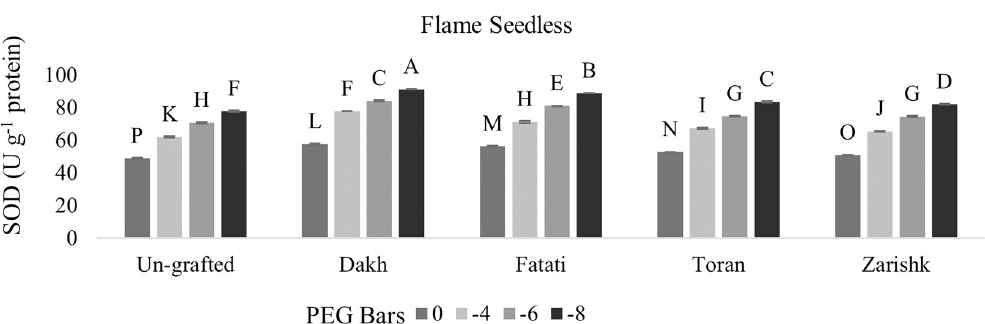
Fig 10. Superoxidase dismutase (SOD) enzymatic activity of un-grafted and grafted Flame Seedless scion variety grafted on different wild grapevines under drought stress condition. Data is represented as mean SD and letters showed significant difference at p < 0.05.